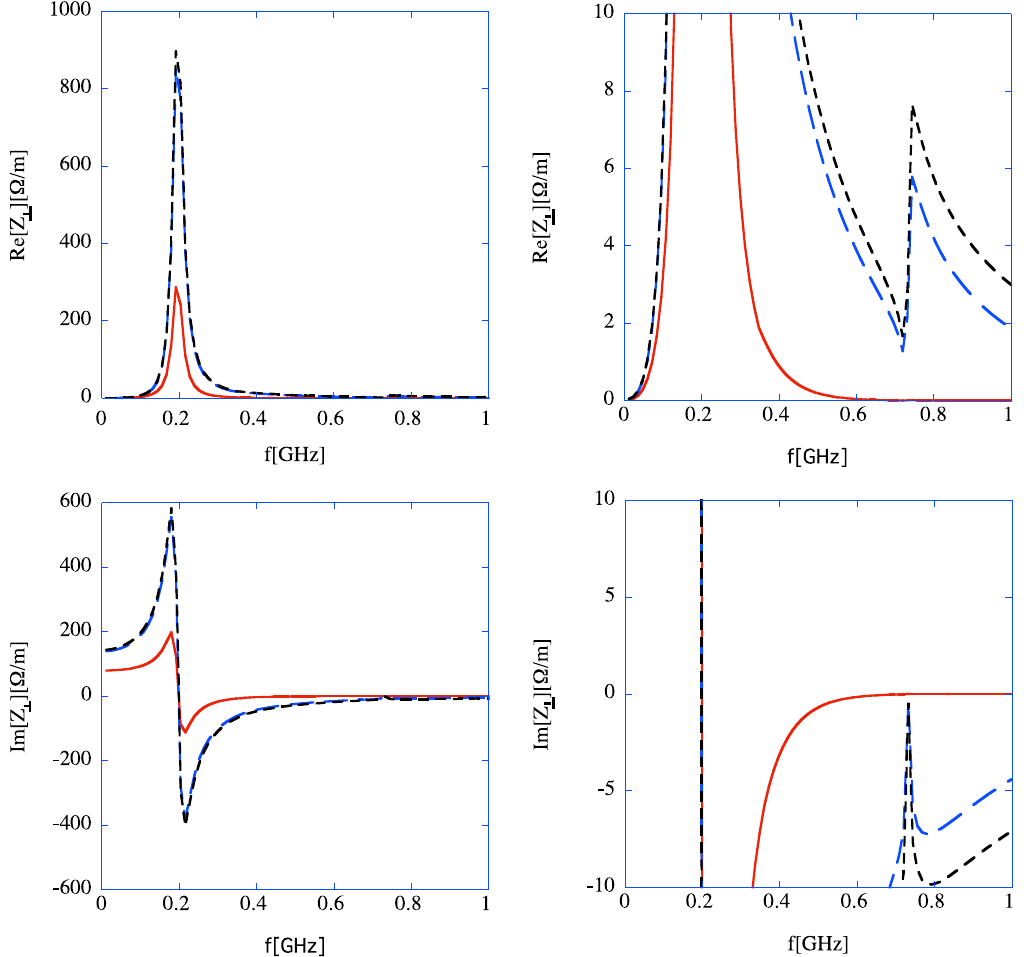
FIG. 8. (Color) The dependence of transverse impedance on Lorentz factor (cid:6) . We assume the chamber with large radius a (cid:4) 250 mm . The red, blue, and black curves represent (cid:6) (cid:4) 1 : 2 , (cid:6) (cid:4) 4 , and (cid:6) (cid:4) 1000 cases, respectively. The top and the bottom figures show the real and the imaginary parts of transverse impedance, respectively. The results for the nonrelativistic beam are smaller than those for the relativistic